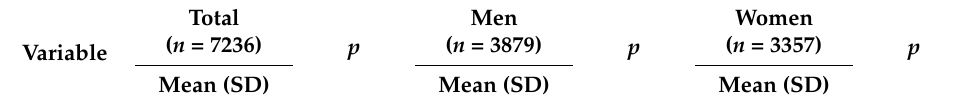
Table 5. Cognitive function in different patterns of grandparent caregiving.